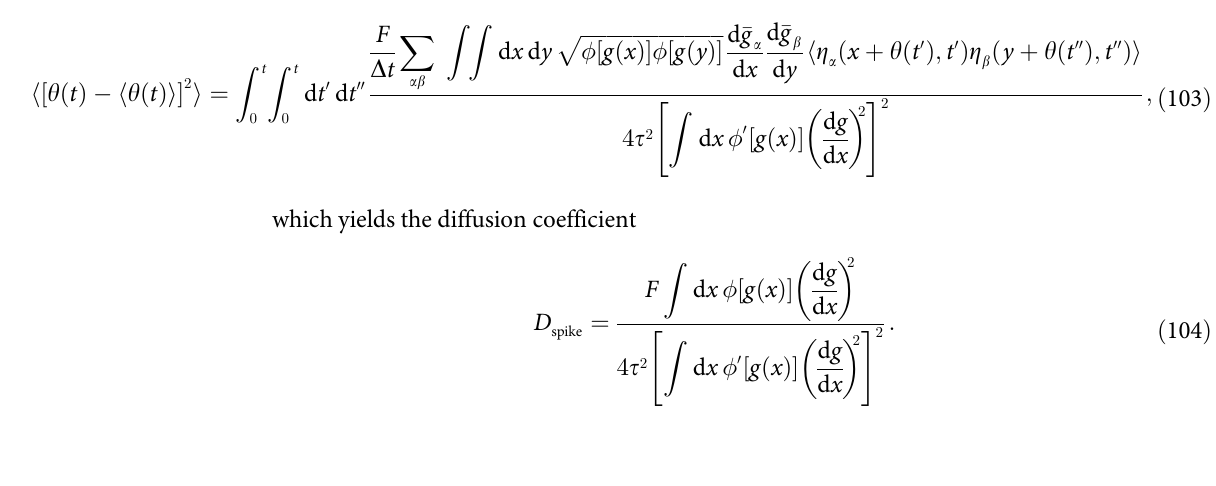
ffiffiffiffiffiffiffiffiffiffiffiffiffiffiffiffiffiffiffiffiffiffiffiffiffiffiffiffi � ½ g ð x Þ� � ½ g ð y Þ�